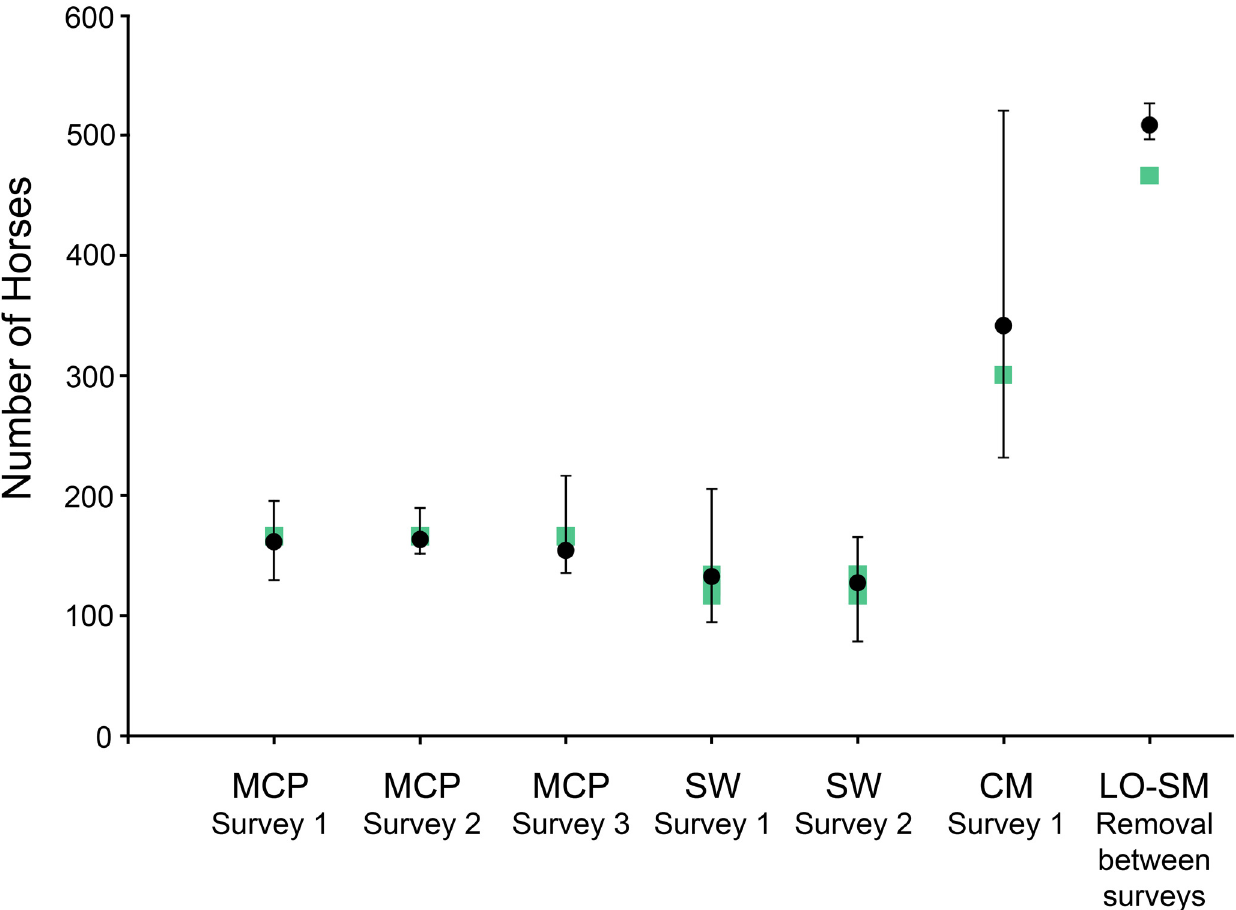
Fig 2. Comparison of estimates to known abundance for aerial surveys of feral horse ( Equus caballus ) populations. Abundance estimates or change in abundance (black dots) and 95% confidence intervals for aerial surveys of feral horse ( Equus caballus ) populations in the western USA, using a hybrid double-observer method. Ranges of known population sizes are shown in green. Surveyed U.S. Bureau of Land Management Herd Management Areas (HMA): McCullough Peaks HMA, Wyoming (MCP); Sand Wash HMA, Colorado (SW); Cedar Mountain HMA, Utah (CM); and Little Owyhee-Snowstorm Mountains HMAs, Nevada (LO-SM).